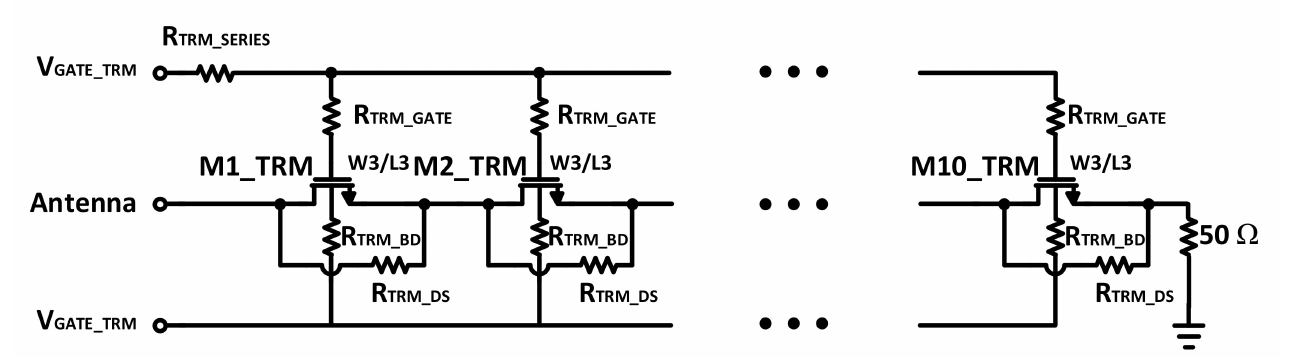
Figure 3. The proposed termination path for the termination